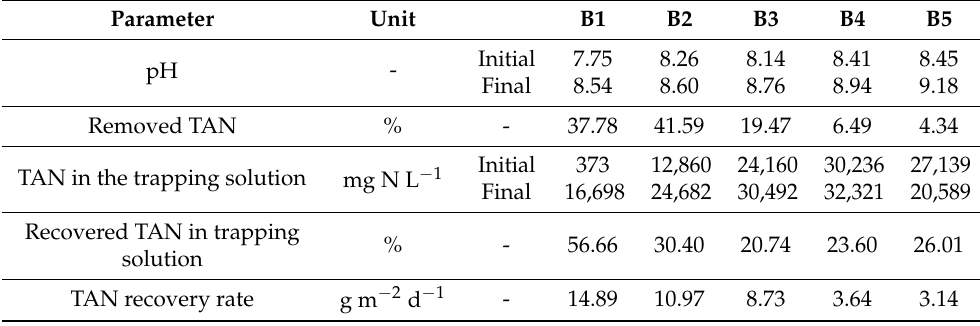
Table 4. Chemical changes in digestate during Experiment II (fed-batch